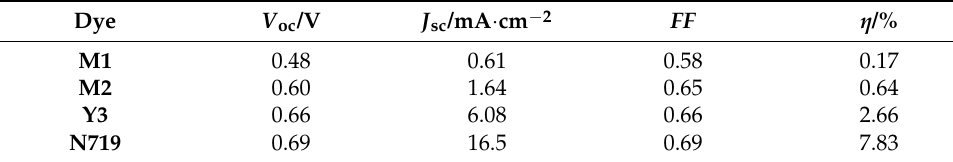
Figure 4. Current-voltage characteristics of dye-sensitized solar cells based on M1 , M2 , and Y3 ( a ) under irradiation and ( b ) in the dark. Table 4. Photovoltaic performances of M1 , M2, and Y3 1